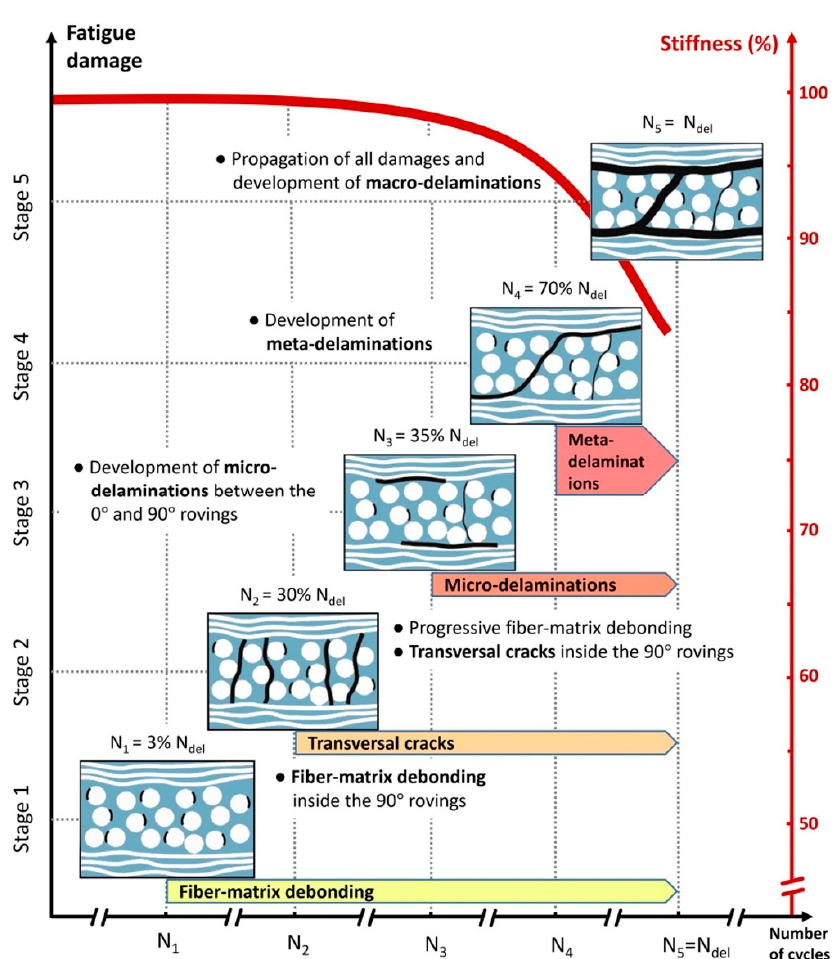
Figure 38. Characterizing fatigue damage propagation of CF-PPS within different stages, adapted with permission from Ref. [58]. Copyright © 2021 Elsevier Ltd. [123].